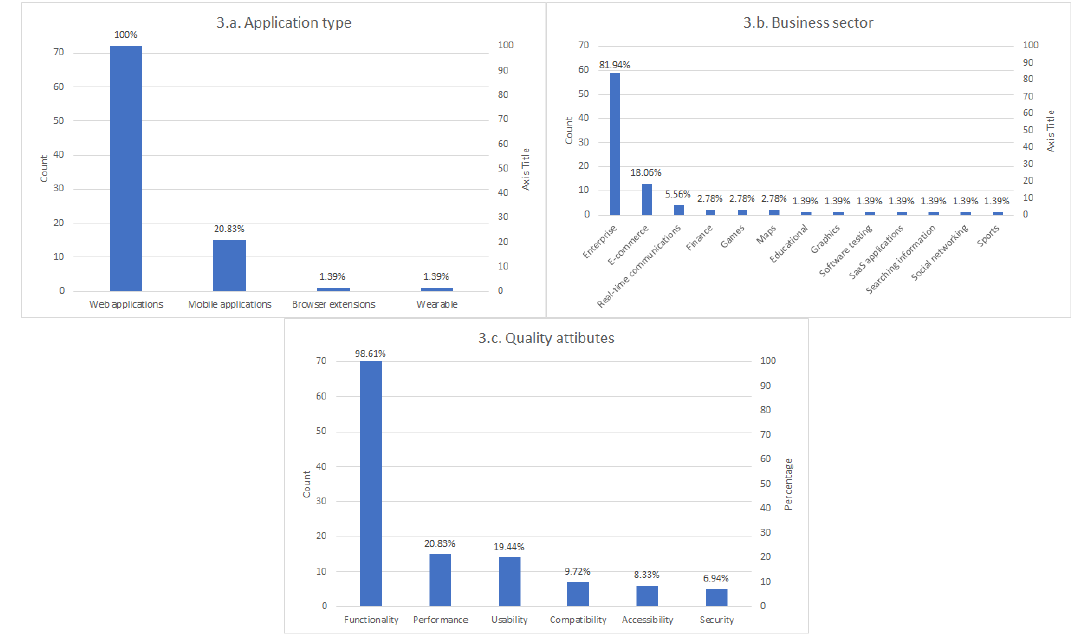
Figure 9. Application type, business sector, and quality